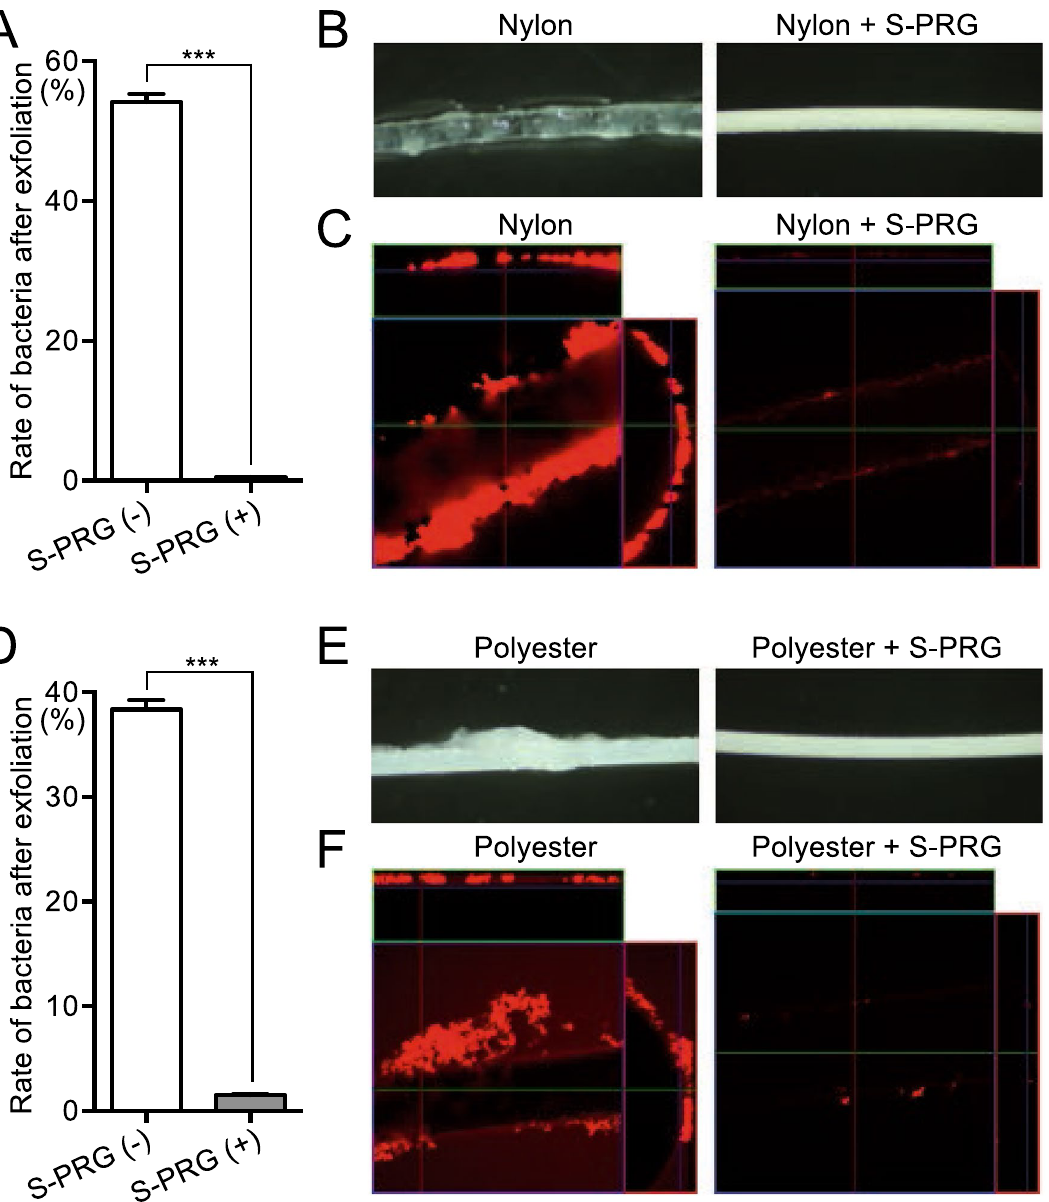
Figure 5. Adhesive properties of S. mutans to monofilaments. ( A ) Rate of S. mutans remaining on nylon monofilaments with and without S-PRG filler after vortexing for 3 s. Significant differences were determined using a chi-square test. *** P < 0.001 between the groups. ( B ) Representative stereomicroscopic images of nylon monofilaments with and without S-PRG filler. ( C ) Representative confocal laser microscopic images of nylon monofilaments with and without S-PRG filler. Orthogonal views of z stacks composed of S. mutans adhering to nylon monofilaments. Bacterial cells adhering to the nylon monofilaments are stained red. ( D ) Rate of S. mutans remaining on polyester monofilaments with and without S-PRG filler after vortexing for 3 s. Significant differences were determined using a chi-square test. *** P < 0.001 between the groups. ( E ) Representative stereomicroscopic images of polyester monofilaments with and without S-PRG filler. ( F ) Representative confocal laser microscopic images of polyester monofilaments with and without S-PRG filler. Orthogonal views of z stacks composed of S. mutans adhering to polyester monofilaments. Bacterial cells adhering to the polyester monofilaments are stained